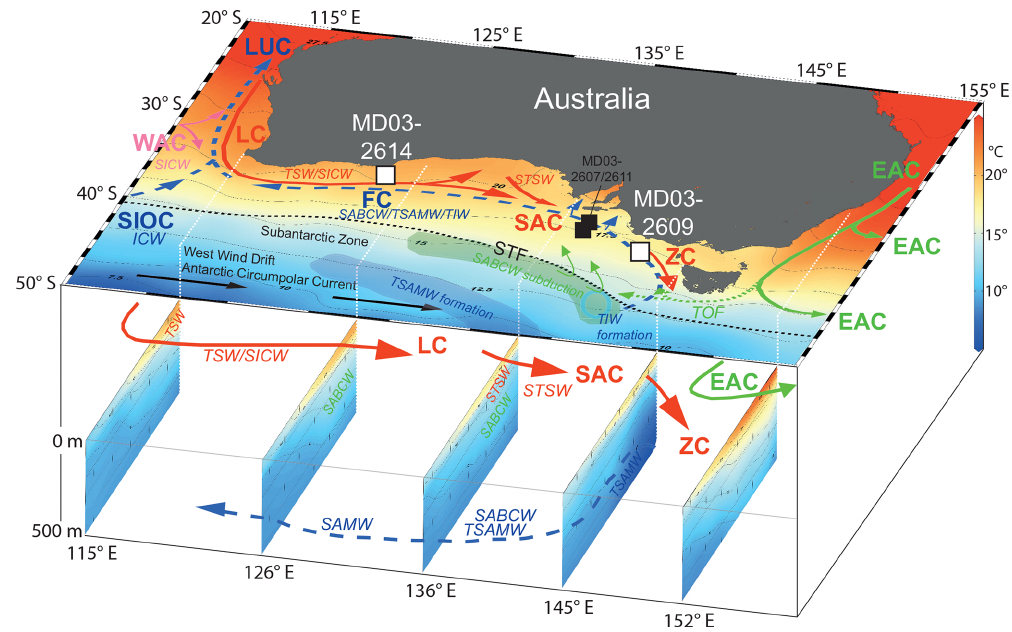
Figure 1. The top of this image shows the regional surface and subsurface circulation pattern off southern Australia underlain by the modern annual SST pattern (using Ocean Data View v. 5.1.7; Schlitzer, 2019; World Ocean Atlas, Locarnini et al., 2019). Sediment core locations (MD03-2614 and -2609) studied here are marked by white squares. Black squares are reference sites. Surface currents are shown in red and green: LC is the Leeuwin Current, WAC is the West Australian Current, SIOC is the South Indian Ocean Current, SAC is the South Australian Current, ZC is the Zeehan Current, EAC is the East Australian Current, and TOF is the Tasman Outflow. Subsurface currents are shown in blue: FC is the Flinders Current, and LUC is the Leeuwin Undercurrent. Water masses transported by currents: TSW is Tropical Surface Water, ICW is Indian Central Water, SICW is South Indian Central Water, STSW is Subtropical Surface Water, SABCW is South Australian Basin Central Water, SAMW is Subantarctic Mode Water, TSAMW is Tasmanian Subantarctic Mode Water, and TIW is Tasmanian Intermediate Water. Sites of SABCW, TIW, and TSAMW formation are indicated. STF is the Subtropical Front (dashed black line). The bottom of the image shows the N–S-oriented temperature profiles (February) of the upper 500m (dotted white lines; using Ocean Data View v. 5.1.7; Schlitzer, 2019). Currents, water masses, and sites of mode and intermediate water formation are from Richardson et al.